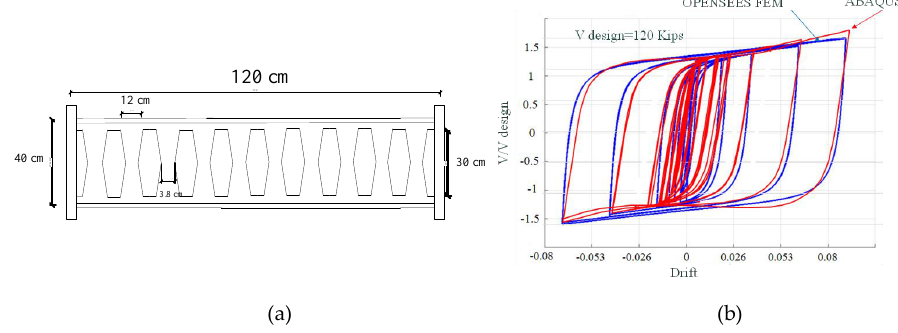
Figure 7. Verification of OpenSees modeling methodology with FEA results based on AISC 341 loading protocol for EBF. ( a ) Butterfly-shaped beam ; ( b ) Verification study .